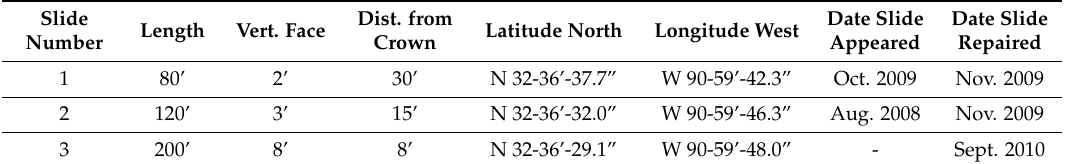
Table 1. Ground truth data from the Mississippi Levee Board.